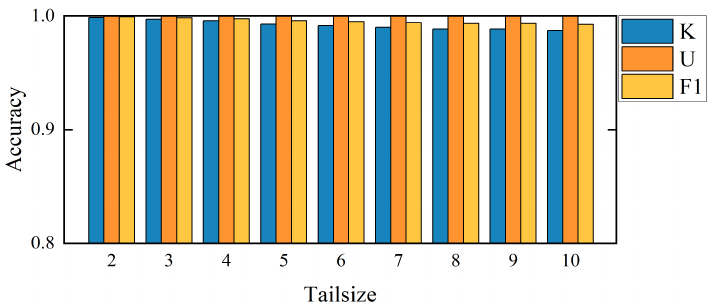
Figure 11. The relationship between the tailsize value and precision of the CWRU dataset.